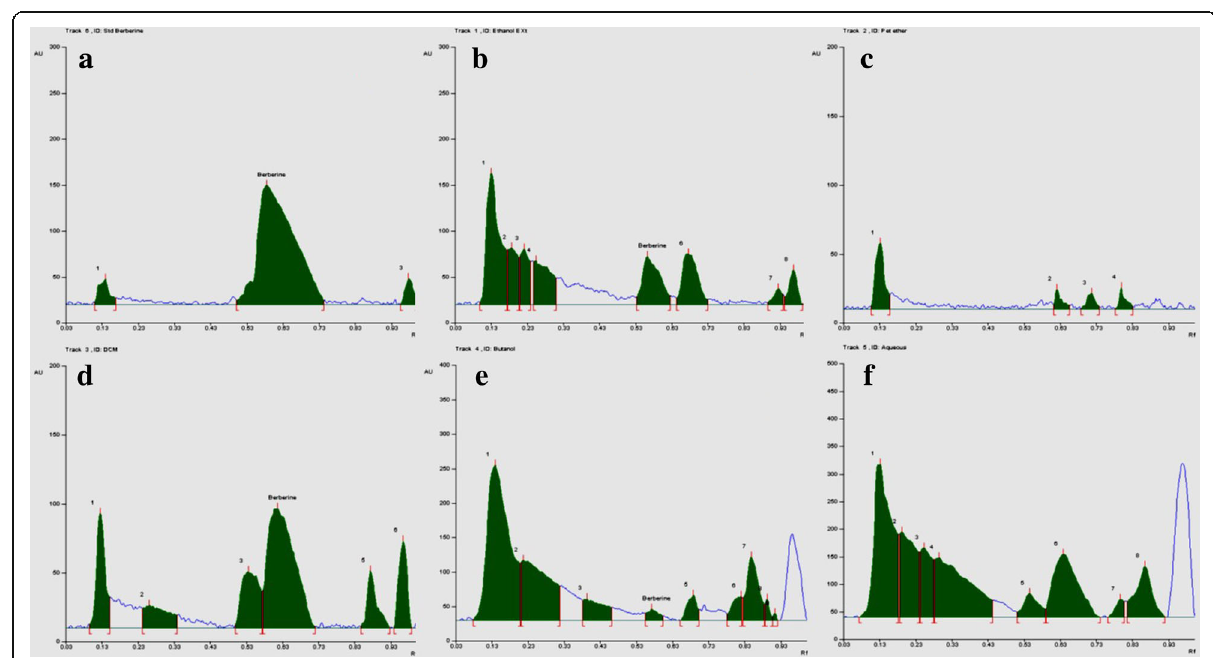
Fig. 4 Estimation of berberine in T cordifolia ethanol extract and its fractions. Representative chromatograms illustrate High Performance Thin Layer Chromatography (HPTLC) of berberine. ( a ) Standard berberine b ) ethanol extract (TCE) ( c ) Petroleum ether fraction (TCP) ( d ) Dichloromethane (TCD) fraction e ) n-Butanol fraction (TCB) and f ) Aqueous fraction (TCA) . Scanned at 350 nm and berberine eluted at R f value of